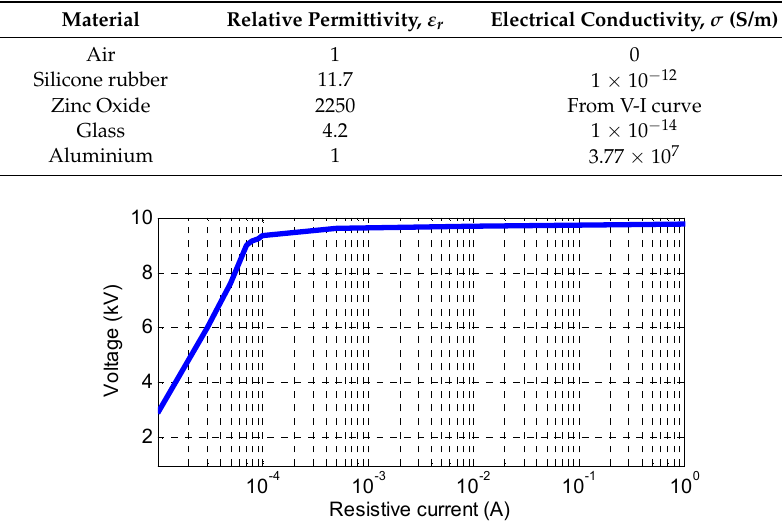
Figure 3. V-I characteristics curve of ZnO varistor.